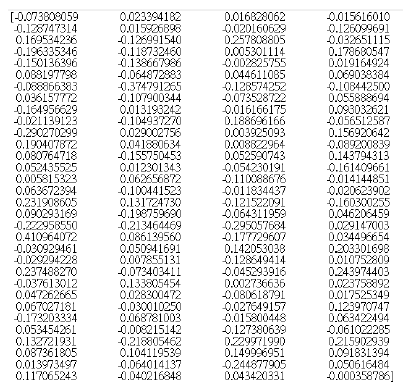
Figure 3. The headshot with complete facial feature. ( a ) The headshot which presents a complete set of facial features. ( b ) The face within the object is extracted from the original headshot and converted to grayscale using OpenCV.